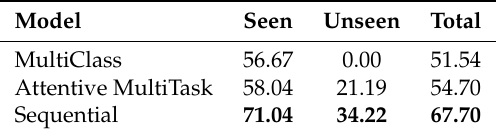
Table 5. The accuracy of the different models on the Kaggle test set comparing the performance of seen and unseen attribute chains. Model Seen